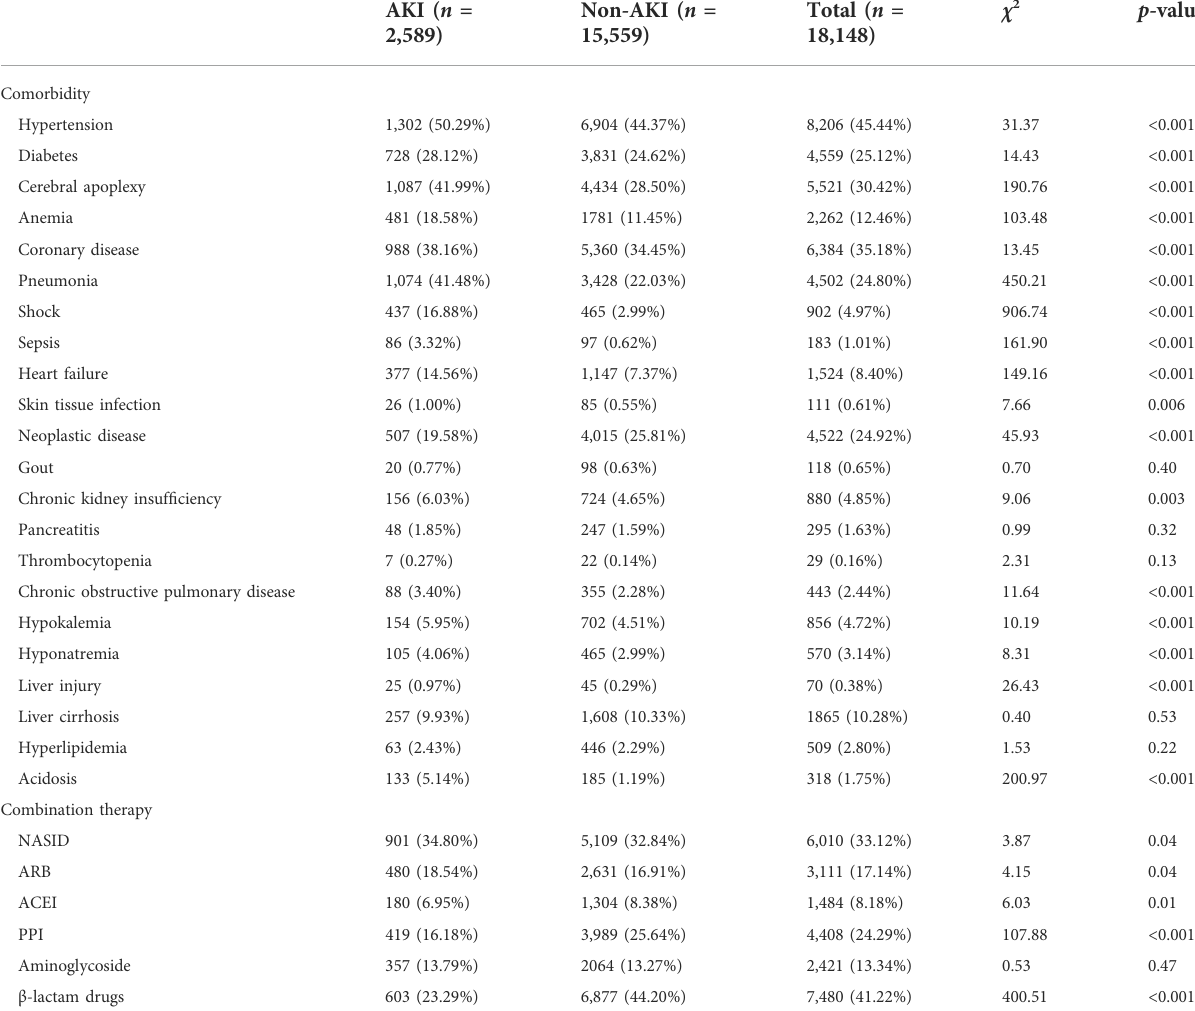
TABLE 3 Comorbidities and concomitant